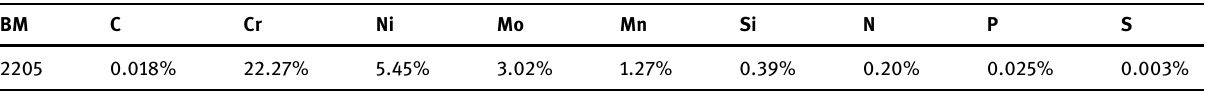
Table 1: Chemical composition of DSS under consideration